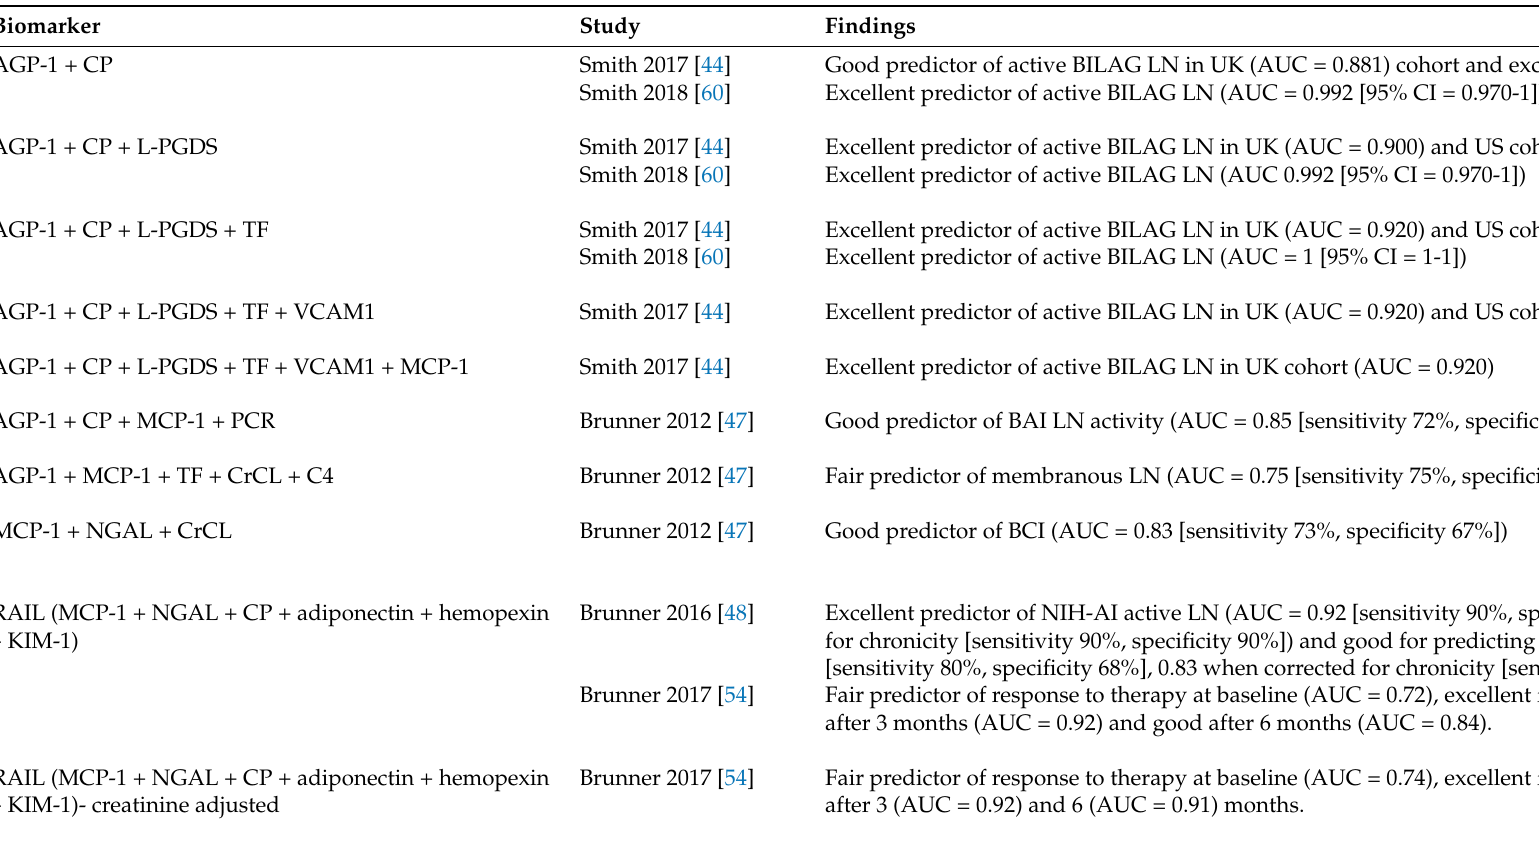
Table 4. Biomarker combination panels in